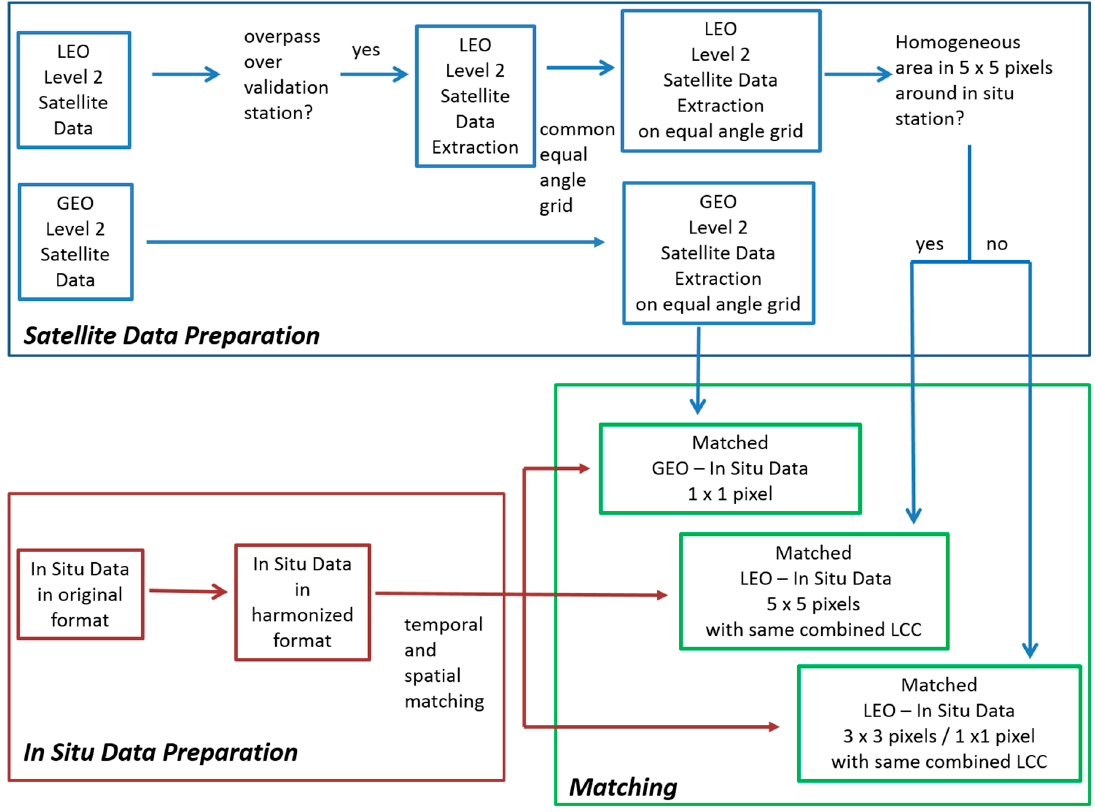
Figure 7. The matching process between satellite and in situ data.